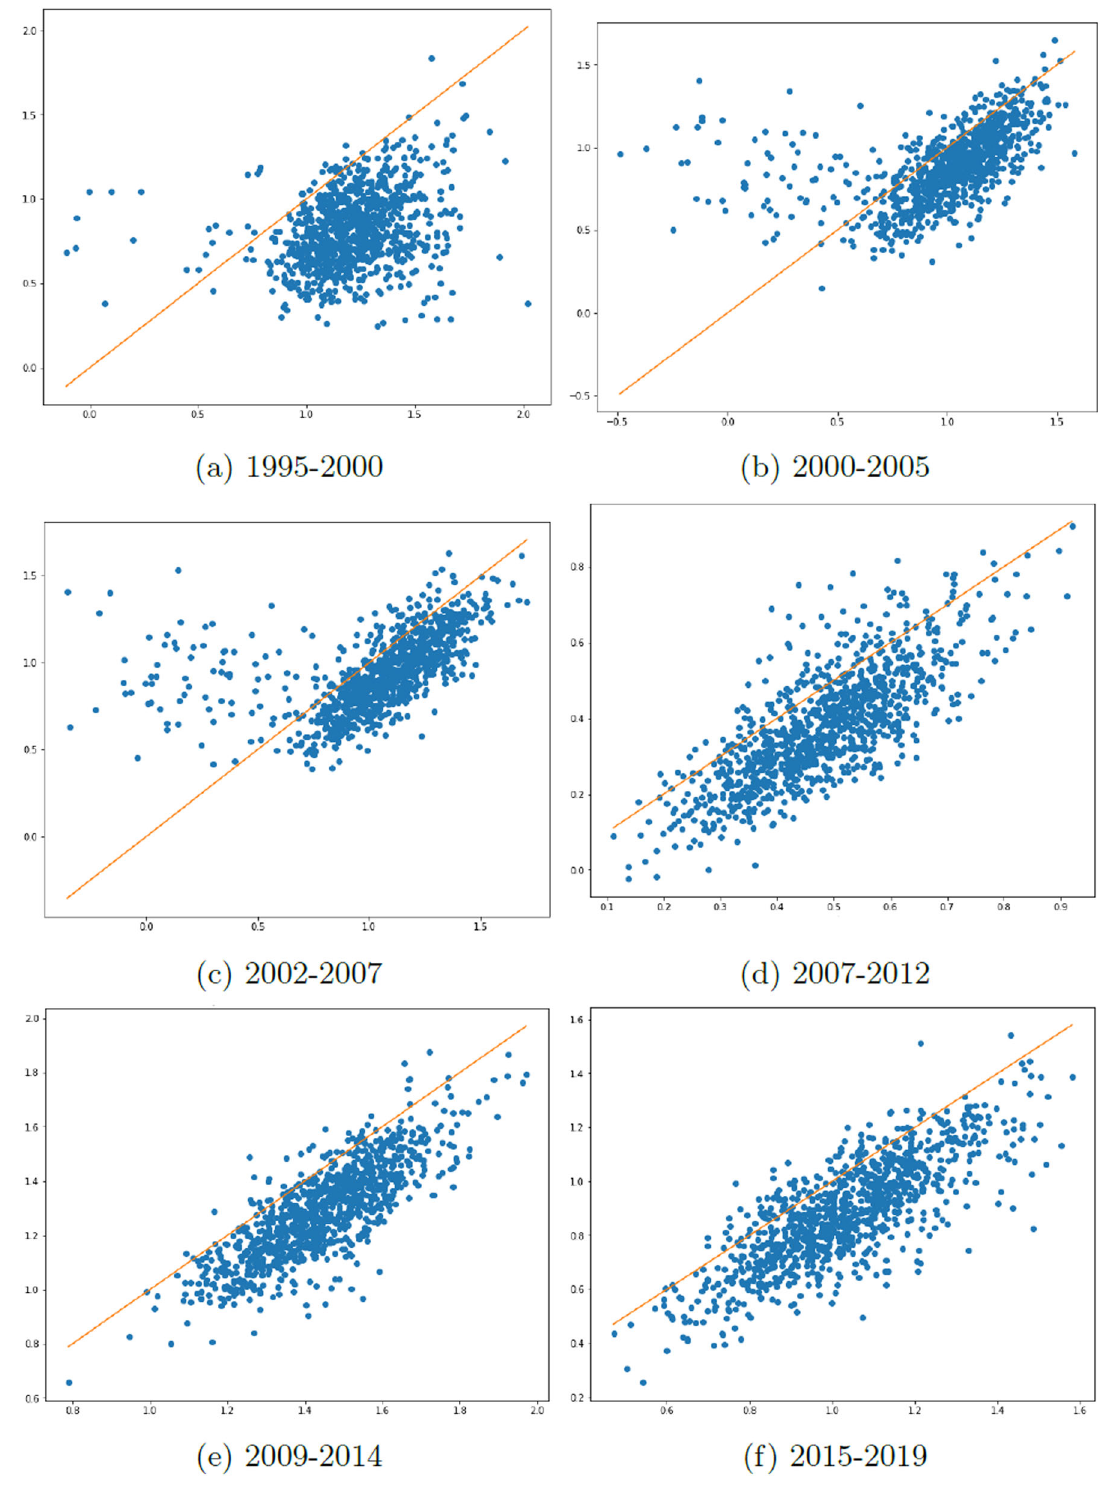
Fig. 2 Sharpe ratio for 5-year samples. The fi rst coordinate is the constrained portfolio, while the second coordinate is the unconstrained